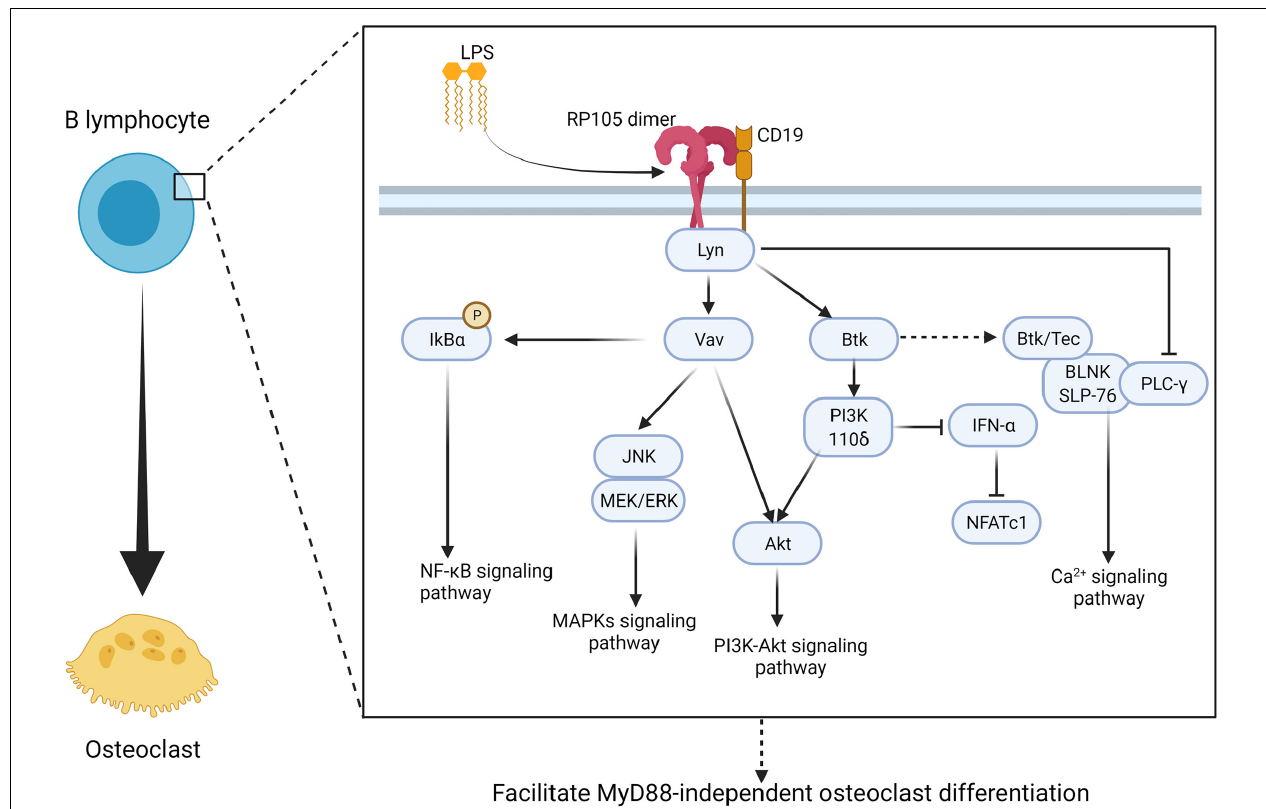
FIGURE 6 | RP105 activates MyD88-independent manner of CD19 + B lymphocyte and promote CD19 + B lymphocyte to derive into osteoclast. RP105/CD19 initiates Lyn activation and phosphorylation then promotes MyD88-independent osteoclast different manner of CD19 + B lymphocyte via two major pathways: (1) promote I κ B α to promote NF- κ B signaling (Yazawa et al., 2003; Hebeis et al., 2005), activate JNK, MEK/ERK to promote MAPKs signaling pathway (Chan et al., 1998; Yazawa et al., 2003; Hebeis et al., 2005), as well as activate Akt to promote PI3K-Akt signaling pathway though a Vav-associated manner (Yu et al., 2015); (2) activate PI3K 110 δ to inhibit IFN- α and promote PI3K-Akt signaling pathway through Btk-associated manner (You et al., 2017). At the same time, Btk also directly promote osteoclastogenesis though Ca 2 + signaling pathway, however, Lyn also inhibit PLC γ -mediated Ca 2 + signaling (Shinohara et al., 2008; Choi et al., 2013). As a result, the regulate signaling axis of osteoclastogenesis in CD19 + B lymphocyte remain to be further discussed. Figure was created using